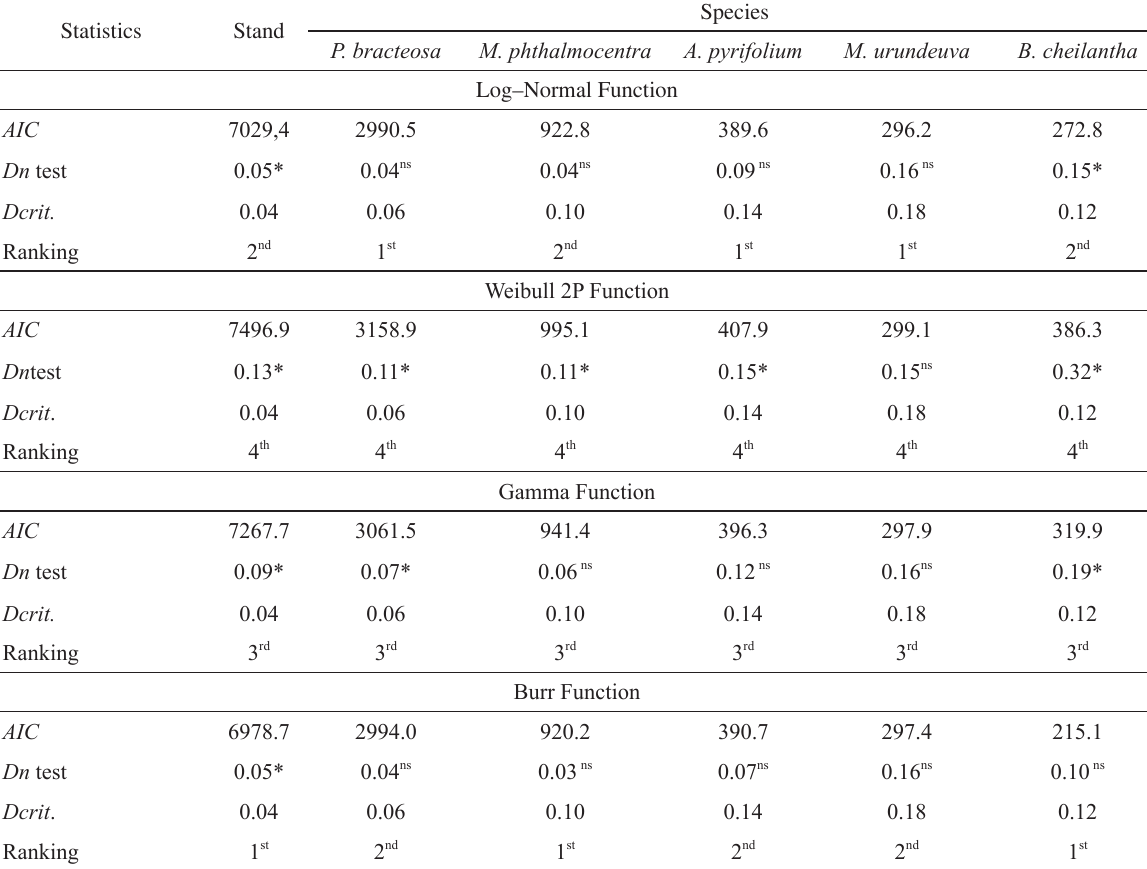
Classification ranking for the diameter distribution models fitted for the stand and HIV species.